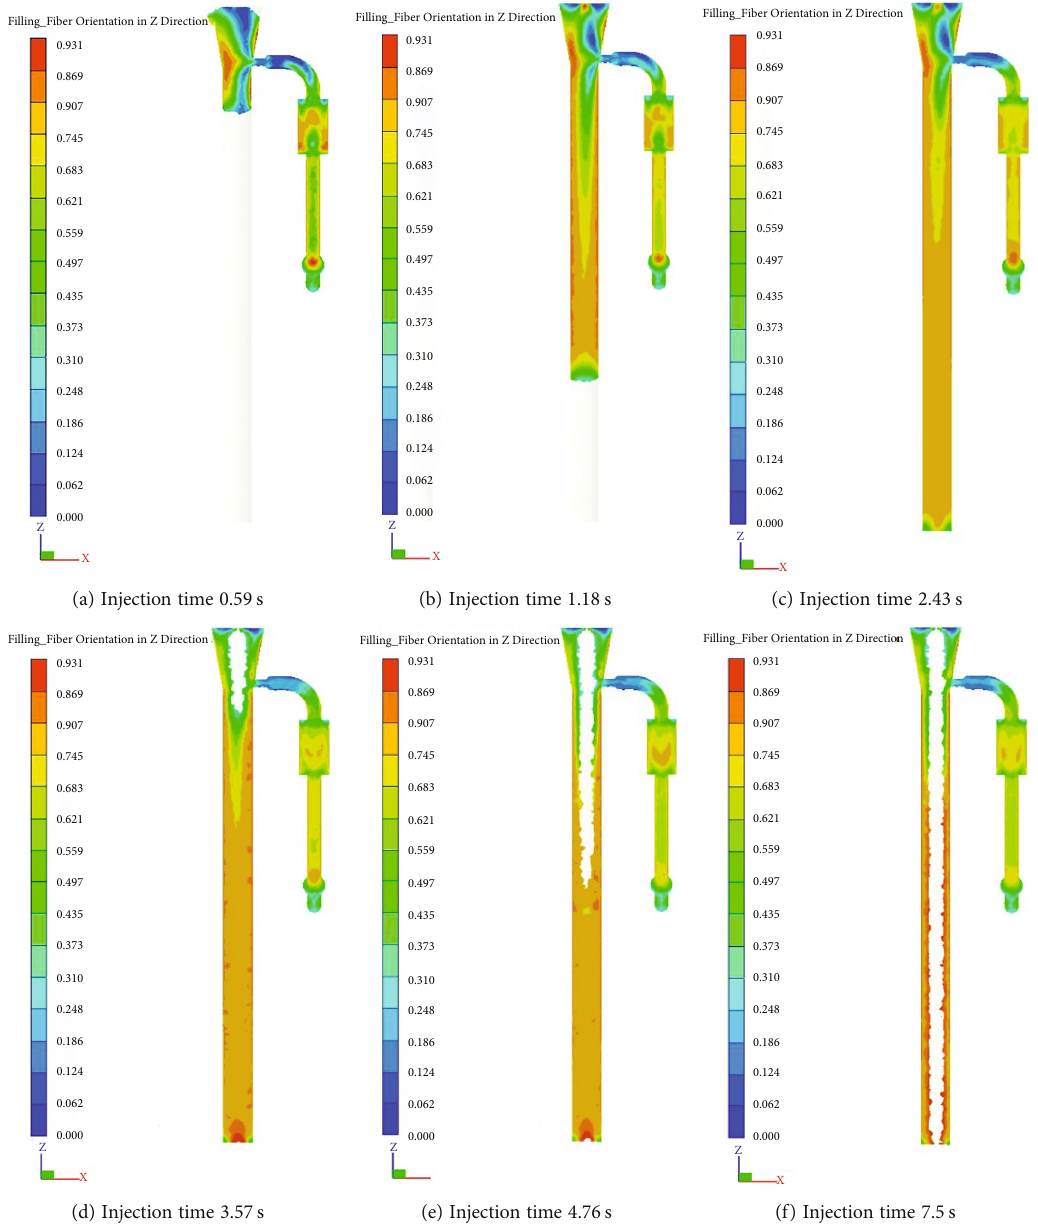
Figure 2: Distribution of fi ber orientation along the fl ow direction in water-assisted injection molding of PP-based composites with 10% fi ber mass